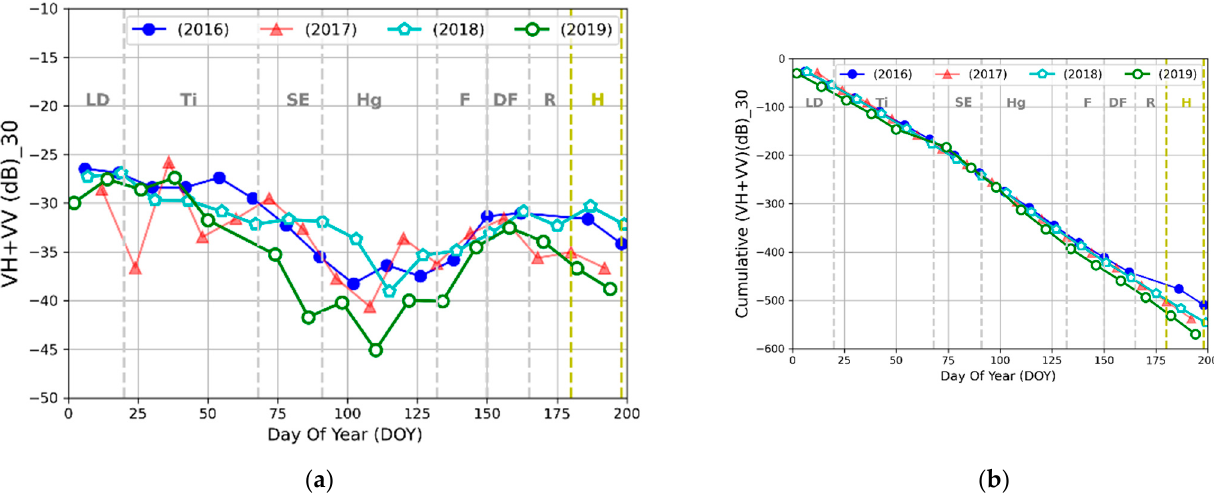
Figure 15. Mean temporal evolution of: ( a ) the VH + VV backscatters and ( b ) its cumulative index acquired at orbit 30 during 2017, 2018 and 2019 years (eight fields of wheat are considered).